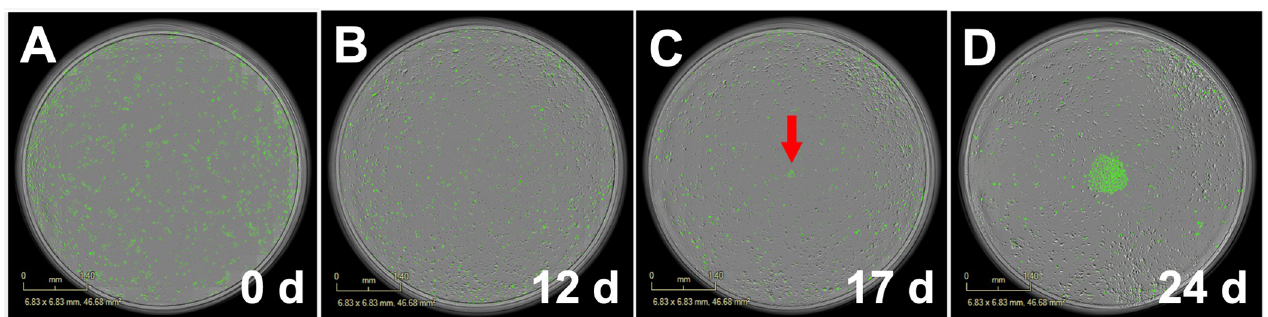
Fig 2. Micrograph example illustrating doxorubicin induced proliferation delay. In this example demonstrating a doxorubicin induced proliferation delay, after exposure to 150 nM doxorubicin at time 0 (A) MCF7 cells stop proliferating and remain in arrest for 315 hours. At 14 days (B), cells have died off in the intervening time, and proliferation has not occurred, and at 21 days (C), proliferation has produced a small patch of cells indicated by the red arrow; proliferation then continues and produces a patch of hundreds of cells by 28 days (D). Untreated cells grow to confluence in approximately four days.